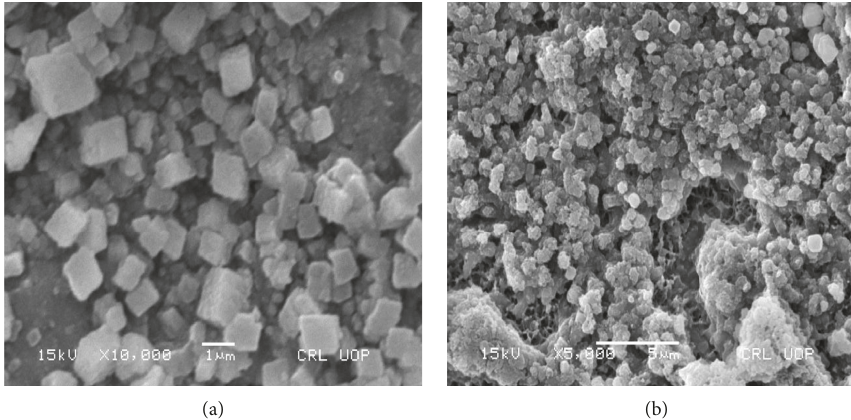
Figure 8: (a) FESEM micrograph of LSP-B specimen. (b) FESEM micrograph of LSP-B specimen precracked at 7 and 28 days.